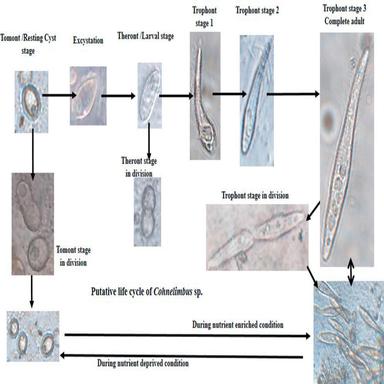
Possible life cycle of Cohnilembus: The sexual and asexual reproduction was observed. Conjugation of two ciliate cells of a compatible mating type was with sexual reproduction. Asexual reproductionby transverse division with the anterior half of the ciliate forming new organism and other posterior half forming another new cell (Trohont stage in division) as complete adult stage (Trophont). Tomont stages was found in division and subsequently developed into theront or larval stages. The theront stages direc